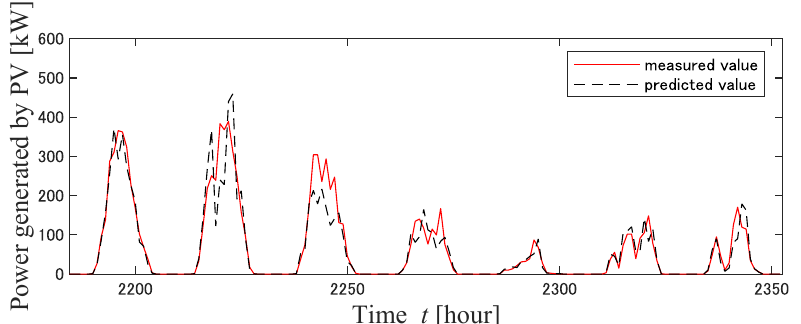
Figure 7. Power generated by PVs (summer).